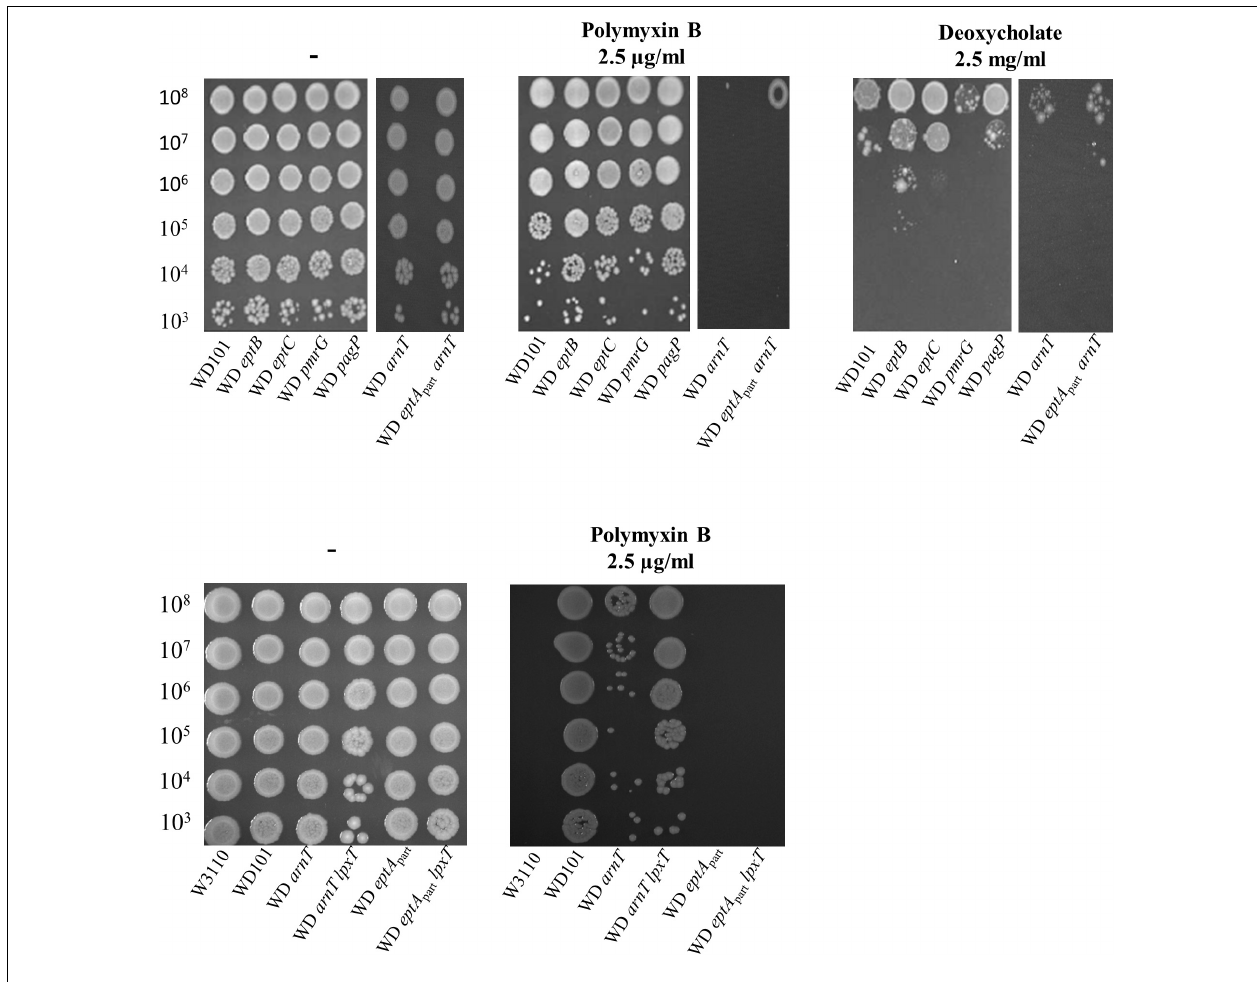
FIGURE 11 | Phenotypic analysis of PmrA constitutive strain and derivatives. WD101 and its derivatives, deleted for various genes encoding different LPS-modifying enzymes, were grown overnight in 2YT medium and 5- µ l spots of serial dilutions were deposited onto 2YT plates containing with or without polymyxin B (2.5 µ g/ml) and deoxycholate (2.5 mg/ml). The data are representative of at least three independent experiments.